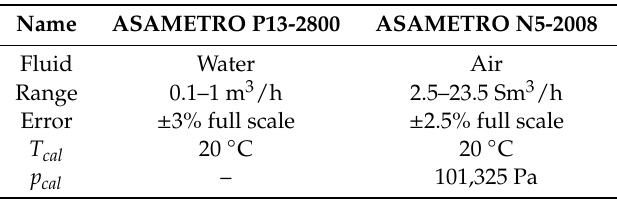
Table 1. Flow-meters characteristics.